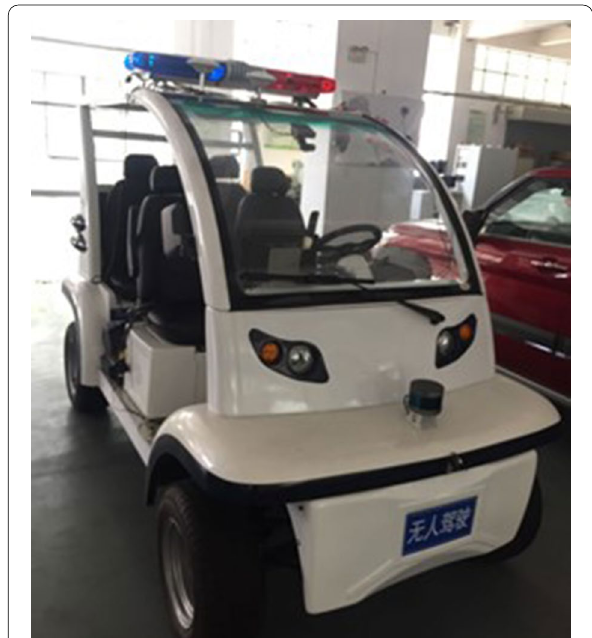
Figure 6 Our self-driving car